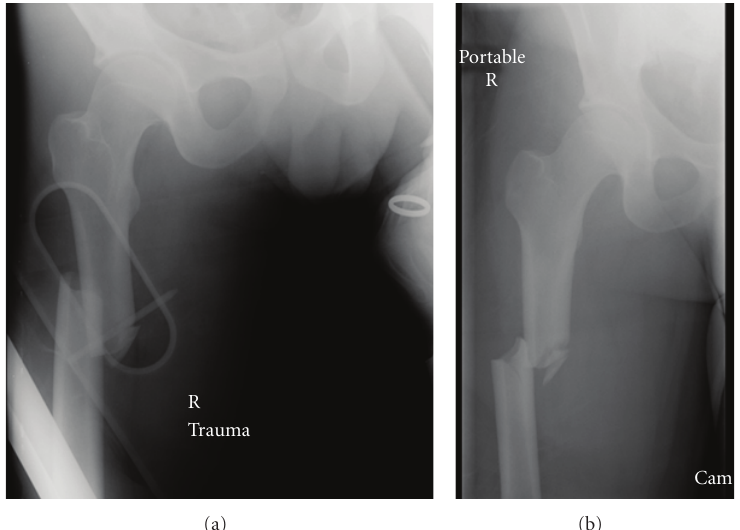
Figure 1: (a) Anteroposterior radiograph of closed right proximal femoral fracture, (b) anteroposterior radiograph of fracture with distal traction applied.